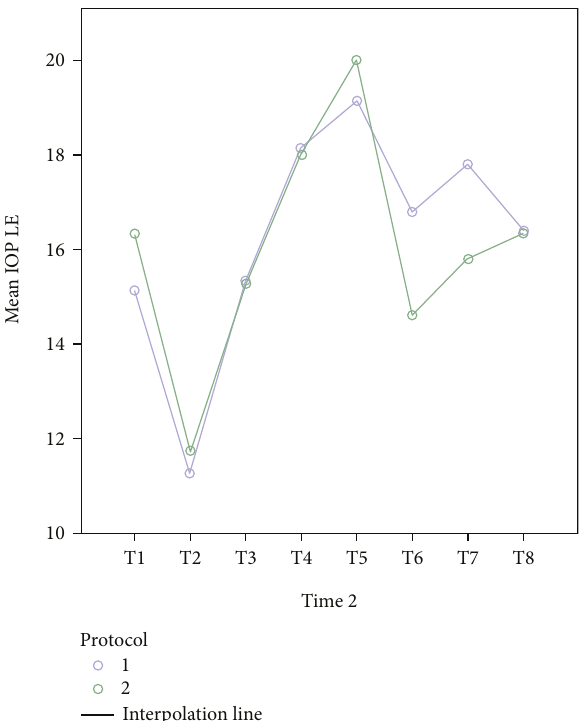
Figure 2: Mean changes of IOP in the right eye (RE) for the two fl uid management protocols. T4 and T5 refer to the time points at which patients were in the Trendelenburg position with CO insu ffl ation of 2 insu ffl ation of the abdomen. 1: liberal fl uid protocol. 2: restrictive fl uid protocol.